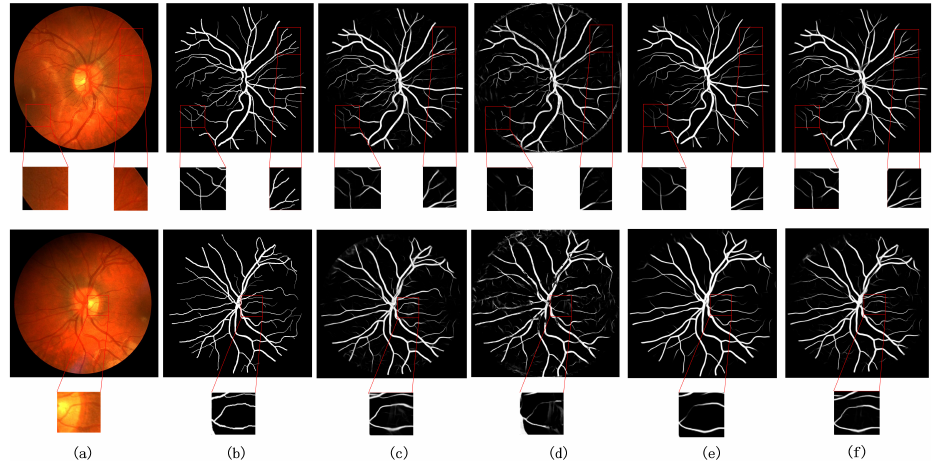
Figure 10. Comparison of visualization results with other methods on CHASE DB1 dataset ( a ) original image, ( b ) groundtruth image, ( c ) UNet++ [13], ( d ) CA-Net [9], ( e ) AG-UNet [52], ( f )